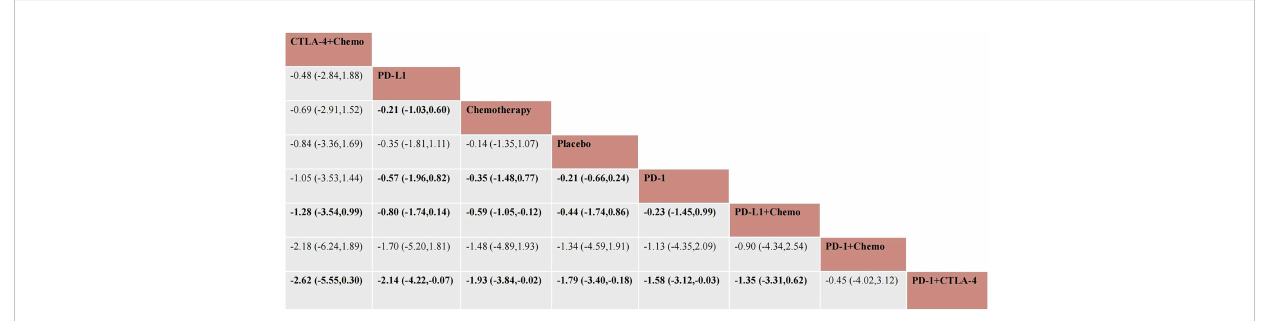
FIGURE 4 Network meta-analysis estimates for cardiotoxicity of different drug species. Ranking of drugs according to cardiac toxicity using SUCRA. The comparison should be read from left to right. Statistically signi fi cant differences are indicated in bold and